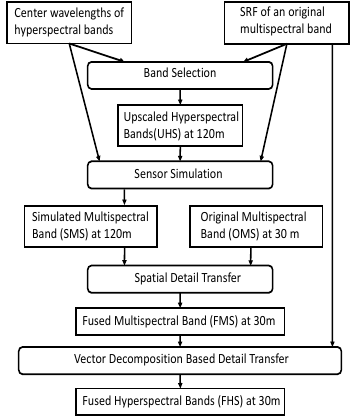
Figure 2: Flowchart of the Algorithm